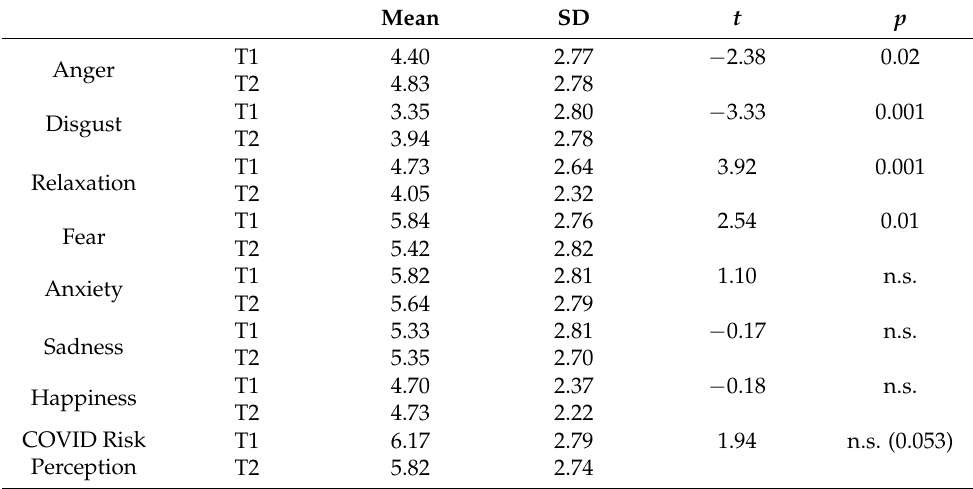
Table 2. Mean and standard deviations (SD) of main emotions and perception of COVID-19 risk in 304 migraine patients. All items were rated on a 0—no emotion reaction to 10—highest emotional reaction